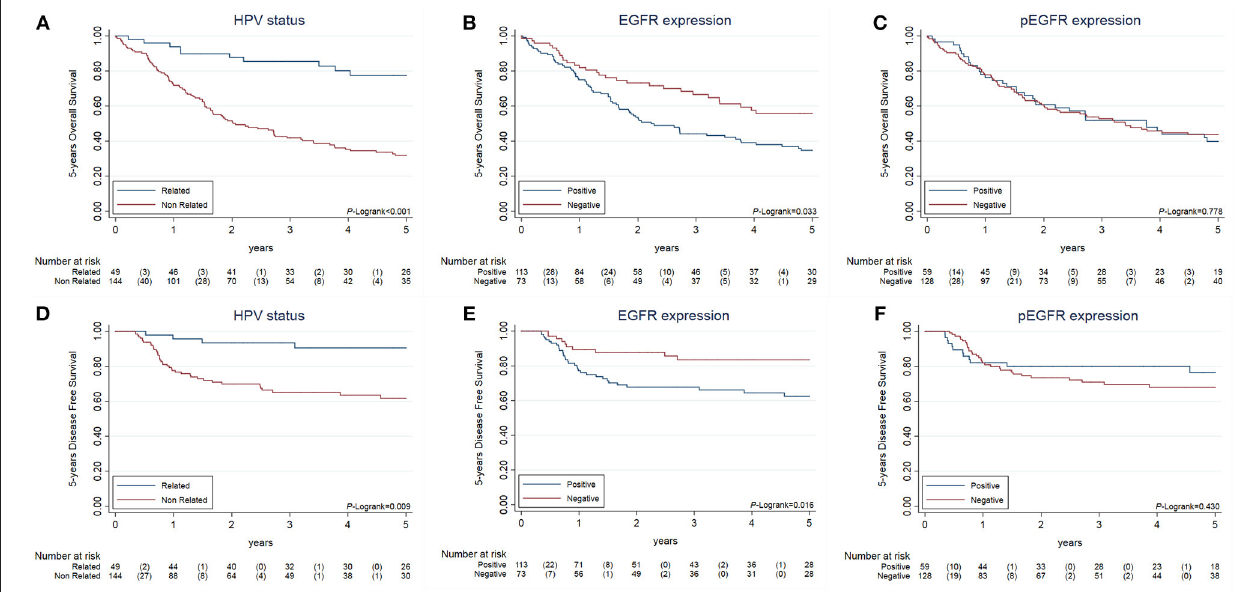
FIGURE 3 | Overall survival and disease free survival of locally-advance OPC patients based on Kaplan-Meier curves stratified by biomarkers. Legend: Data on 5 years Overall Survival (A–C) and 5 years disease free survival (D–F) according to three different biomarkers: HPV16 (A,D) , EGFR (B,E), and pEGFR (C,F) . (A,D) Show OS and DFS Kaplan-Meier curve for HPV16-related and HPV negative samples. (B,E) Show OS and DFS Kaplan-Meier curve for EGFR-positive and EGFR-negative samples. (C,F) Show OS and DFS Kaplan-Meier curve for pEGFR-positive and pEGFR-negative samples.